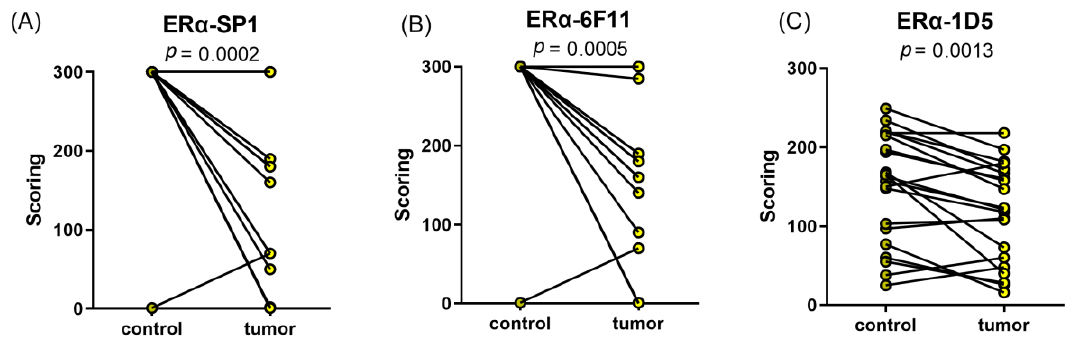
Figure 2. Comparison of ERα IHC staining with monoclonal antibodies SP1, 6F11, and 1D5. ( A ) SP1